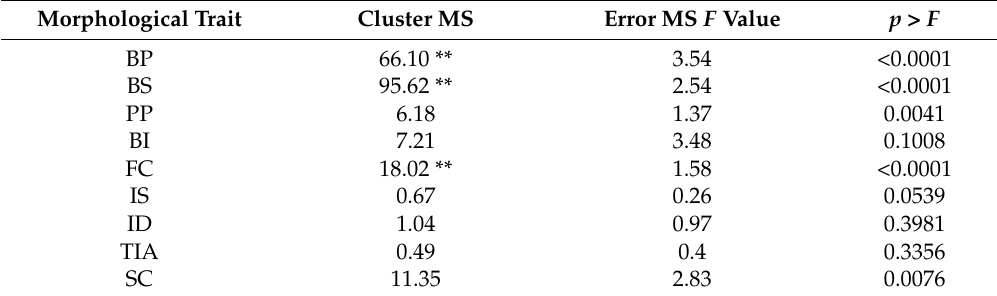
Table 1. Significance of morphological traits on different clusters of SSE